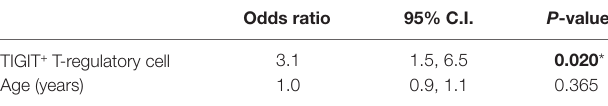
TaBle 5 | Summary of logistic regression model of clinical remission.